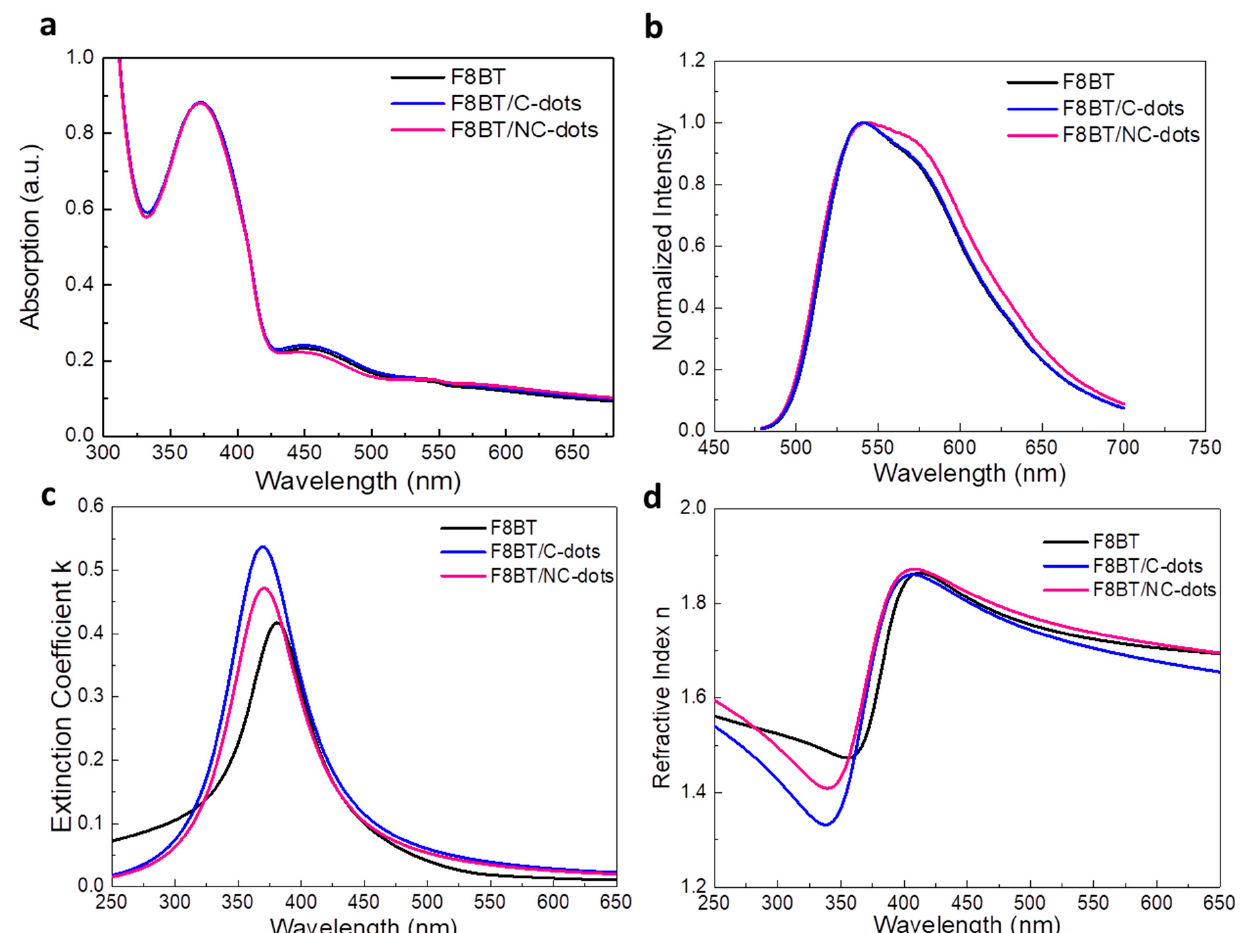
Figure 4. ( a ) UV–Vis absorption and ( b ) steady-state PL spectra of F8BT pristine and coated with C-dots and NC-dots. ( c ) Extinction coefficient and ( d ) refractive index measurements of F8BT and F8BT/C-dot and F8BT/NC-dot interfaces.